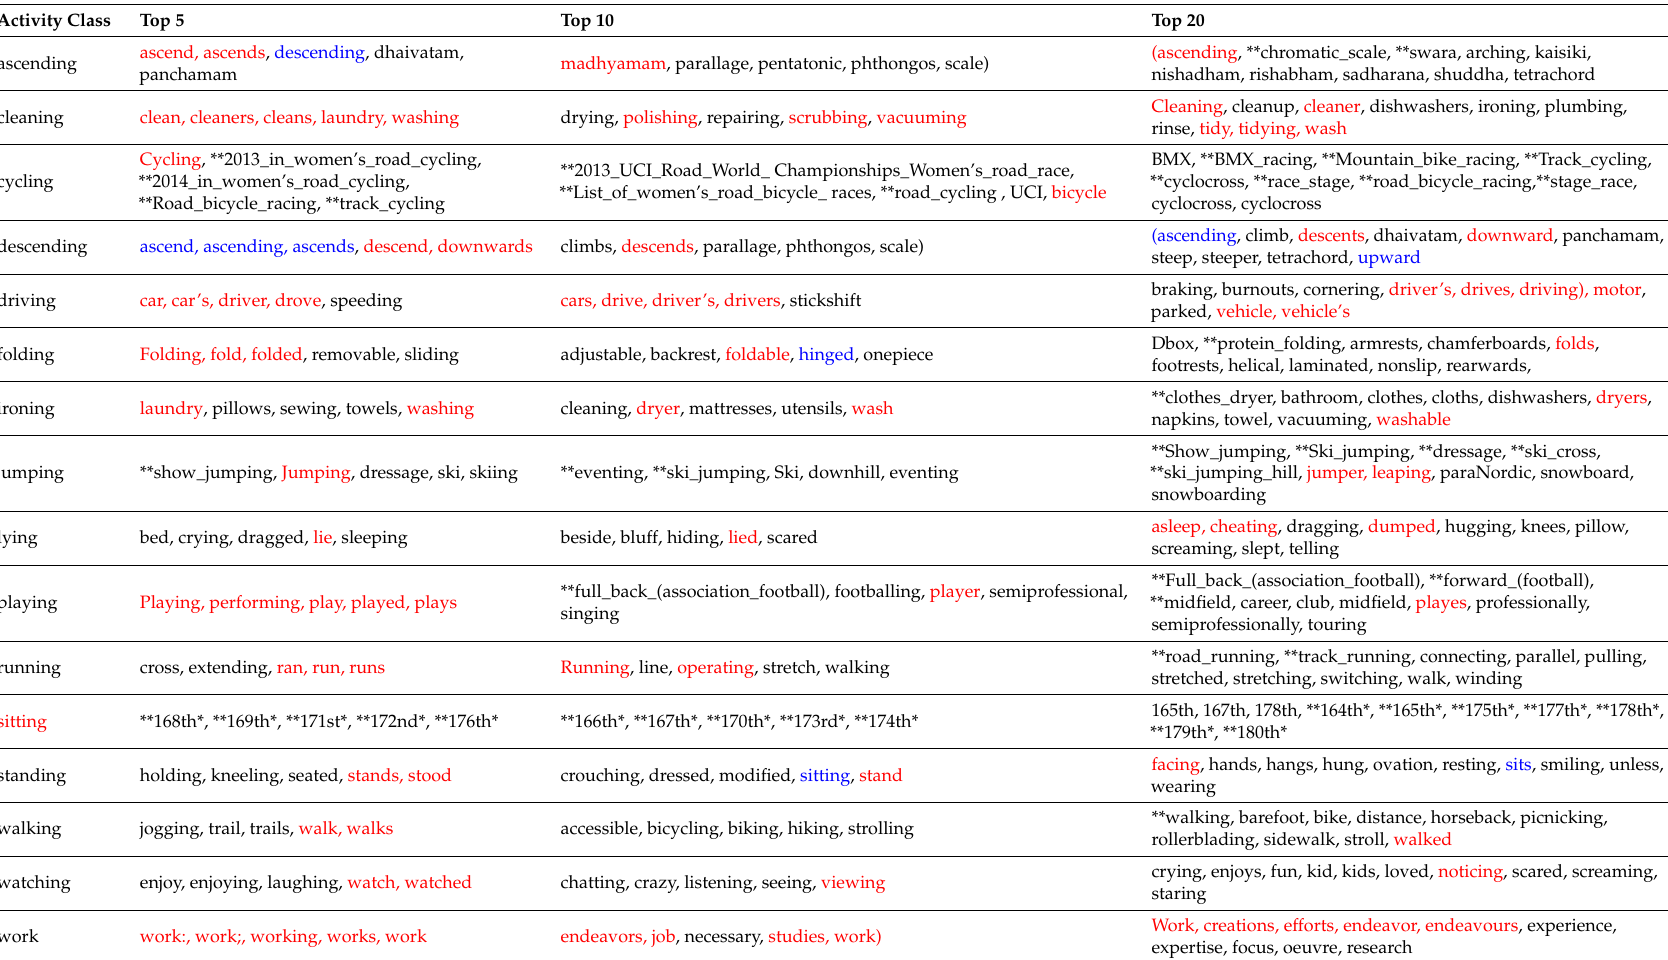
Table A6. Top 20 similar words for each activity class in the PAMAP2 dataset. The symbol ** indicates that “DBPEDIA_ID/” has been omitted; * indicates that “_New_York_State_Legislature” has been omitted. The color of red represent synonyms and blue for